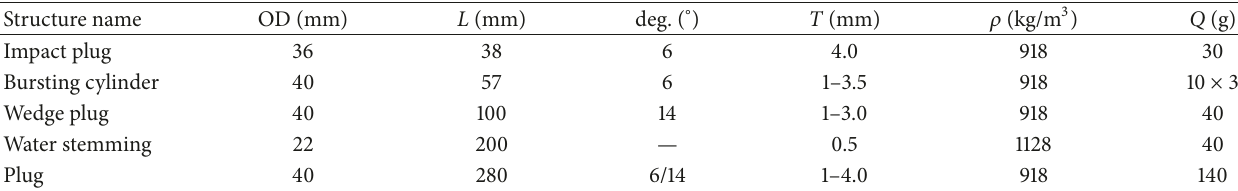
Table 2: Parameters of the blast hole plug.